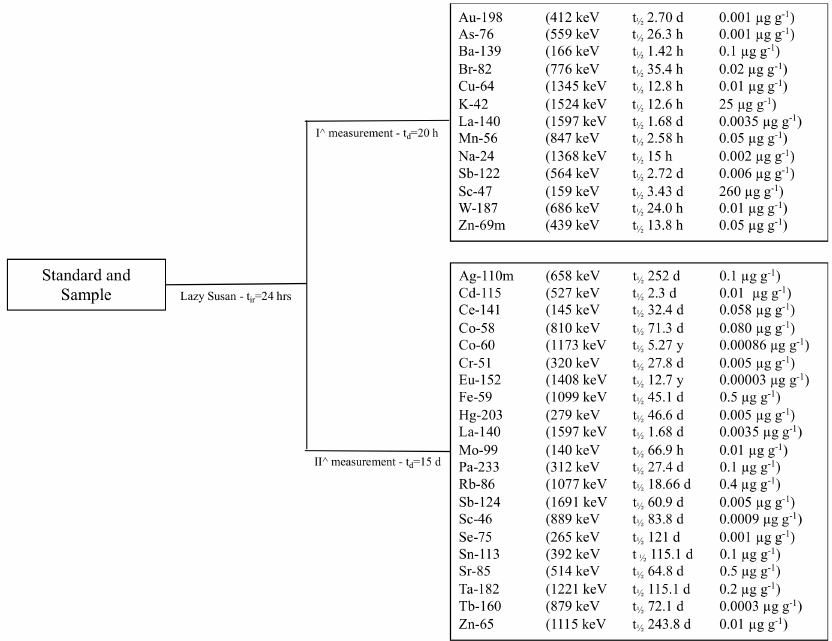
Figure 2. Instrumental Neutron Activation Analysis (INAA) master scheme (t ir irradiation time; t d decay time; t 1 half-life time). In brackets for each product, nuclides are reported as well as some 2 nuclear analytical chemistry parameters, i.e., peak energy (keV), half-life time (m minute, h hour, d day, y year), and limit of detection